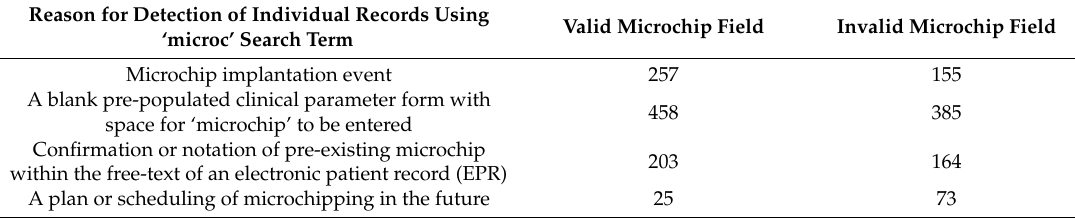
Table 3. Classification of 1000 VetCompass Australia (VCA) electronic patient records returned by the search term ‘microc,’ both for records with valid 15 digit microchip number recorded in the ‘microchip’ field and records with an invalid entry, and common causes of identifying records (other than the record describing an implantation